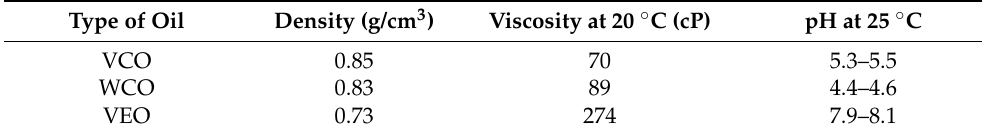
Table 1. Physical properties of the oil used as bitumen rejuvenators. Type of